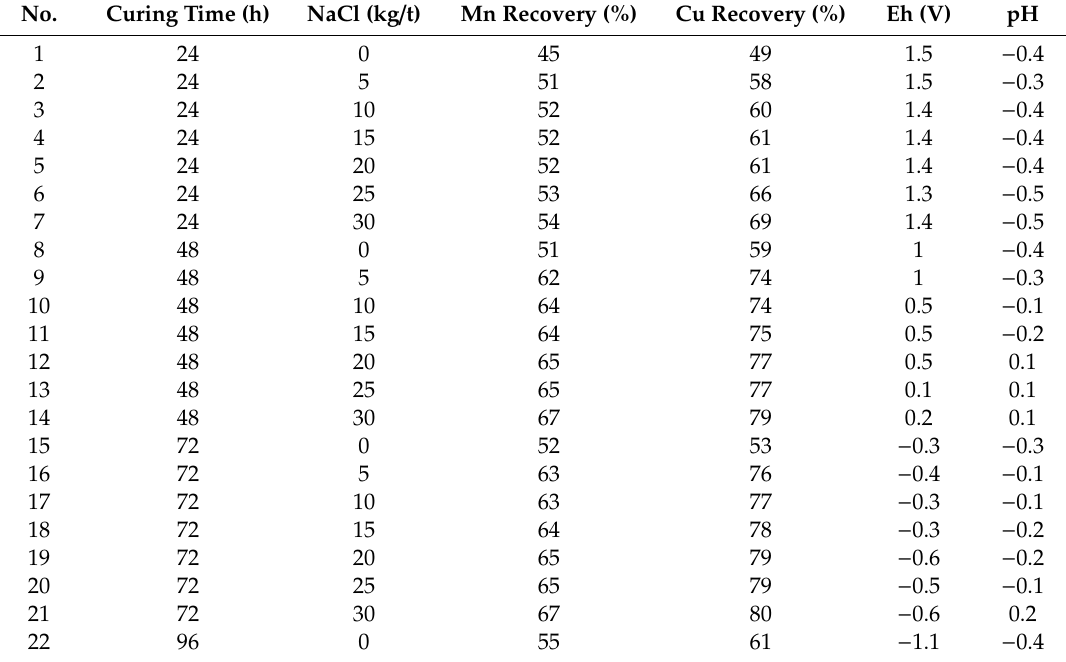
Table A1. Sampling Results of the Experiment